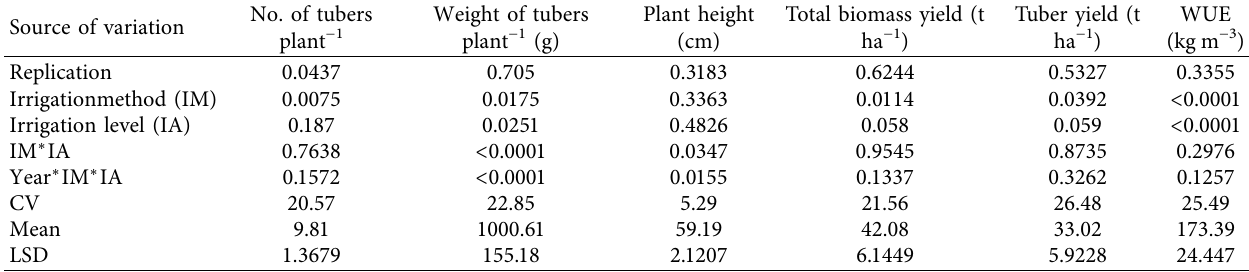
Table 2: Combined analysis of variance of potato tuber yield, yield components and water use efficiency for tuber yield as affected by year, irrigation methods (IMs), and irrigation levels (IAs).